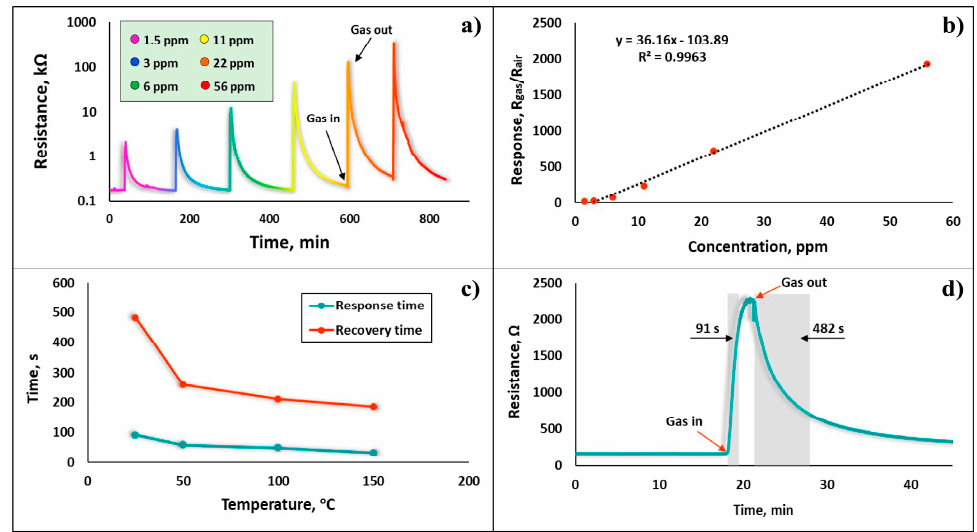
Figure 11. ( a ) dynamic resistance curves of the sensor to the different concentrations of HPV with UV irradiation, ( b ) sensor response vs HPV concentration under UV light, ( c ) dependence of the response and recovery times on the operating temperature under UV light, ( d ) real-time resistance curve of the sensor at 1.5 ppm HPV, representing the response and recovery time under UV irradiation at RT.